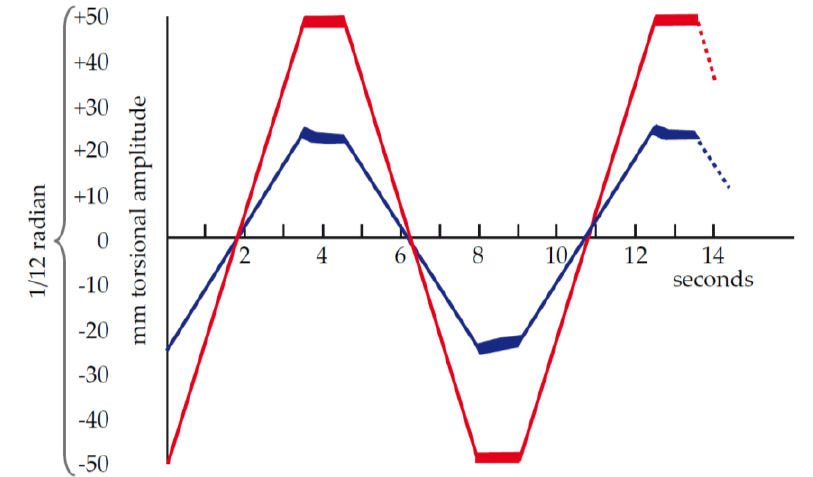
Figure 4. Chart representing the movement of Dr. Hartert’s cup and pin after clotting of the blood sample. The red line represents the displacement of the cup and the blue line represents the displacement of the pin. The units on the x-axis represent the extent of the illuminated section of film by the rotating mirror. The units of mm amplitude on the y-axis remain today in many viscoelastic hemostatic assay systems. The units of mm to express a clot strength has been the source of confusion in this space. Reproduced with permission from [4] .